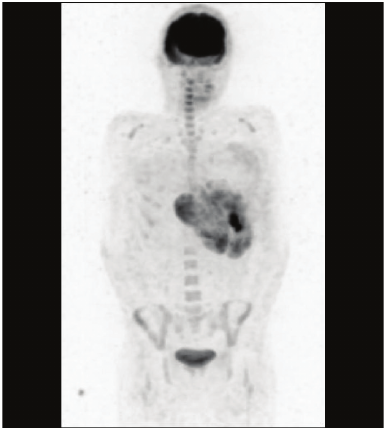
Figure 3: Fluorodeoxyglucose positron emission tomography showing no distant